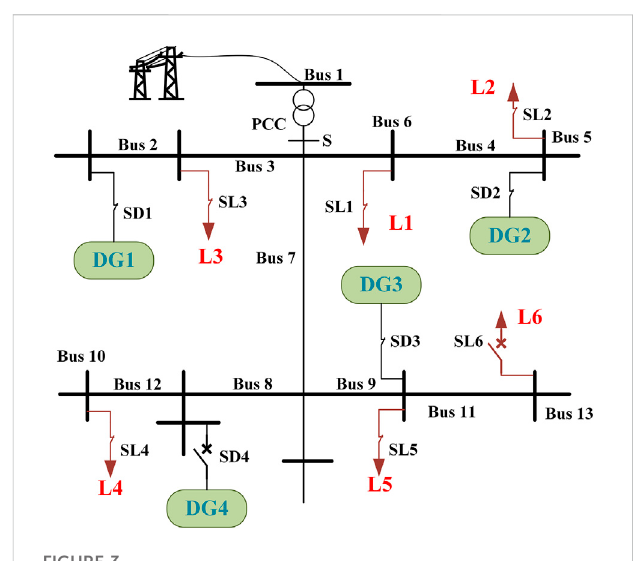
FIGURE 3 MG model based on a modi fi ed IEEE 13-bus